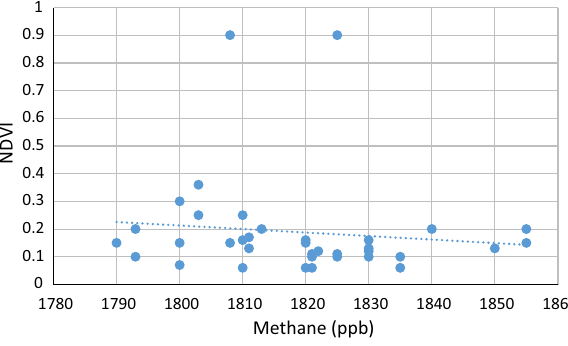
Fig. 5 Relationship between monthly methane and precipitation in